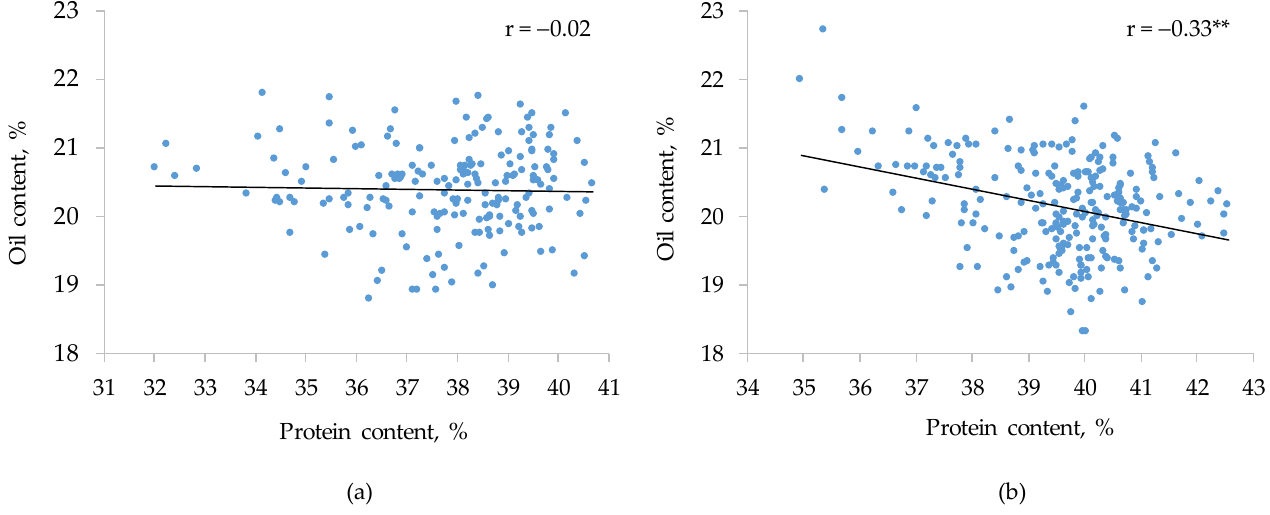
Figure 6. Correlation between protein and oil content ( a ) over 32 genotypes and six dry environments; ( b ) over 32 genotypes and eight normal environments. ** for significance.